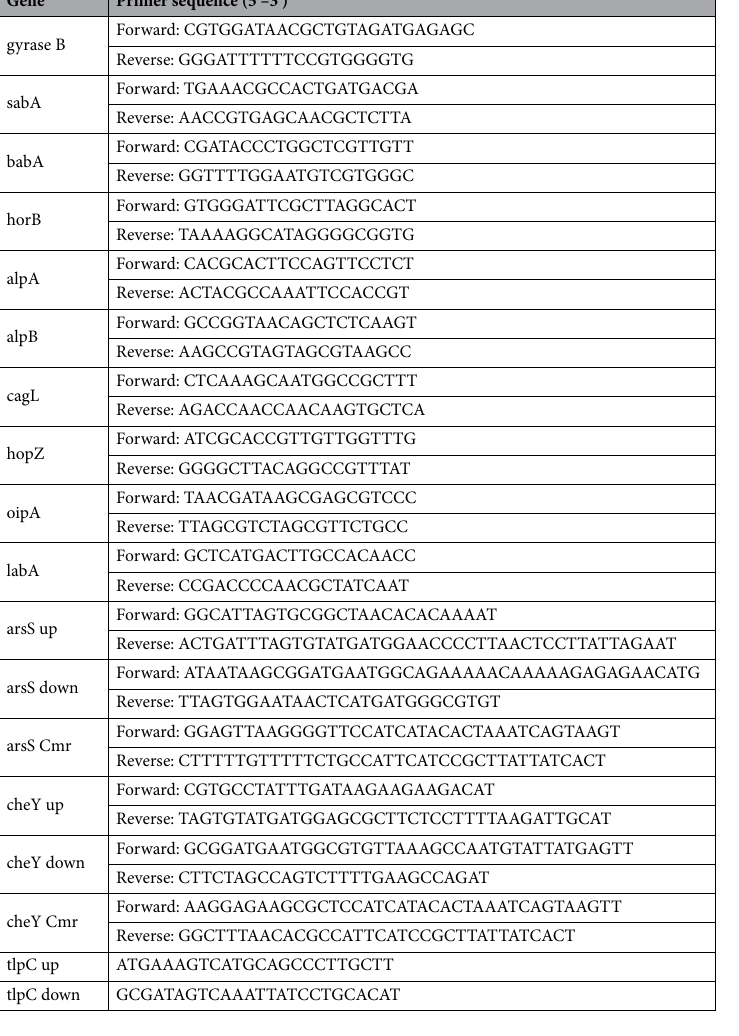
Table 1. Primers used in this